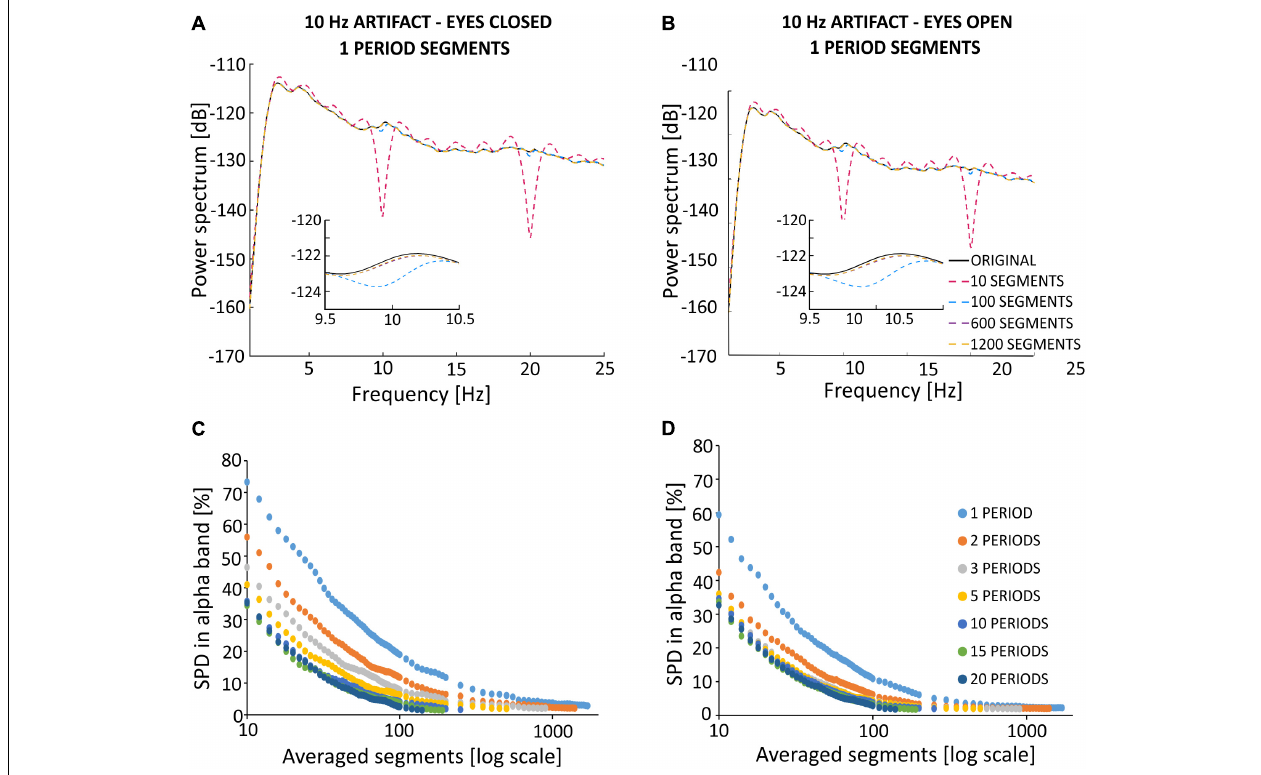
FIGURE 9 | Effects of SMA filtration on EEG signal recorded from the F4 electrode with superimposed artificial stimulation artifact. The F4 electrode is situated closer to the stimulation electrodes than the O2 electrode. Thus, the amplitude of contamination by the stimulation artifact is higher for F4 as compared to O2. (A) Results of simulated filtration prepared on block sh2 (eyes closed). (B) Results of simulated filtration prepared on block sh5 (eyes open). Blocks sh2 and sh5 cause the sham registration in the conditions with eyes closed and eyes open. Spectrum percentage difference (SPD) between the original signal and the signal obtained after removal of the simulated 10 Hz artifact, which varies depending on the averaged segments for a varying number of periods per segment for the eyes closed (C) and eyes open (D) conditions.